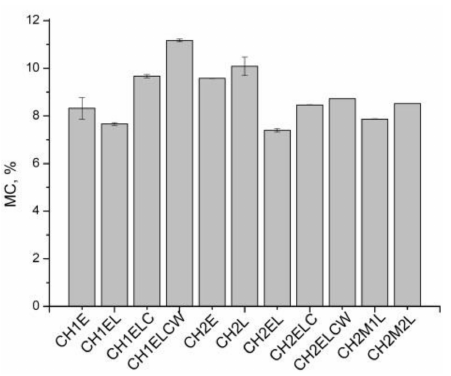
Figure 1. Moisture content (MC) for chitosan/starch-based samples.